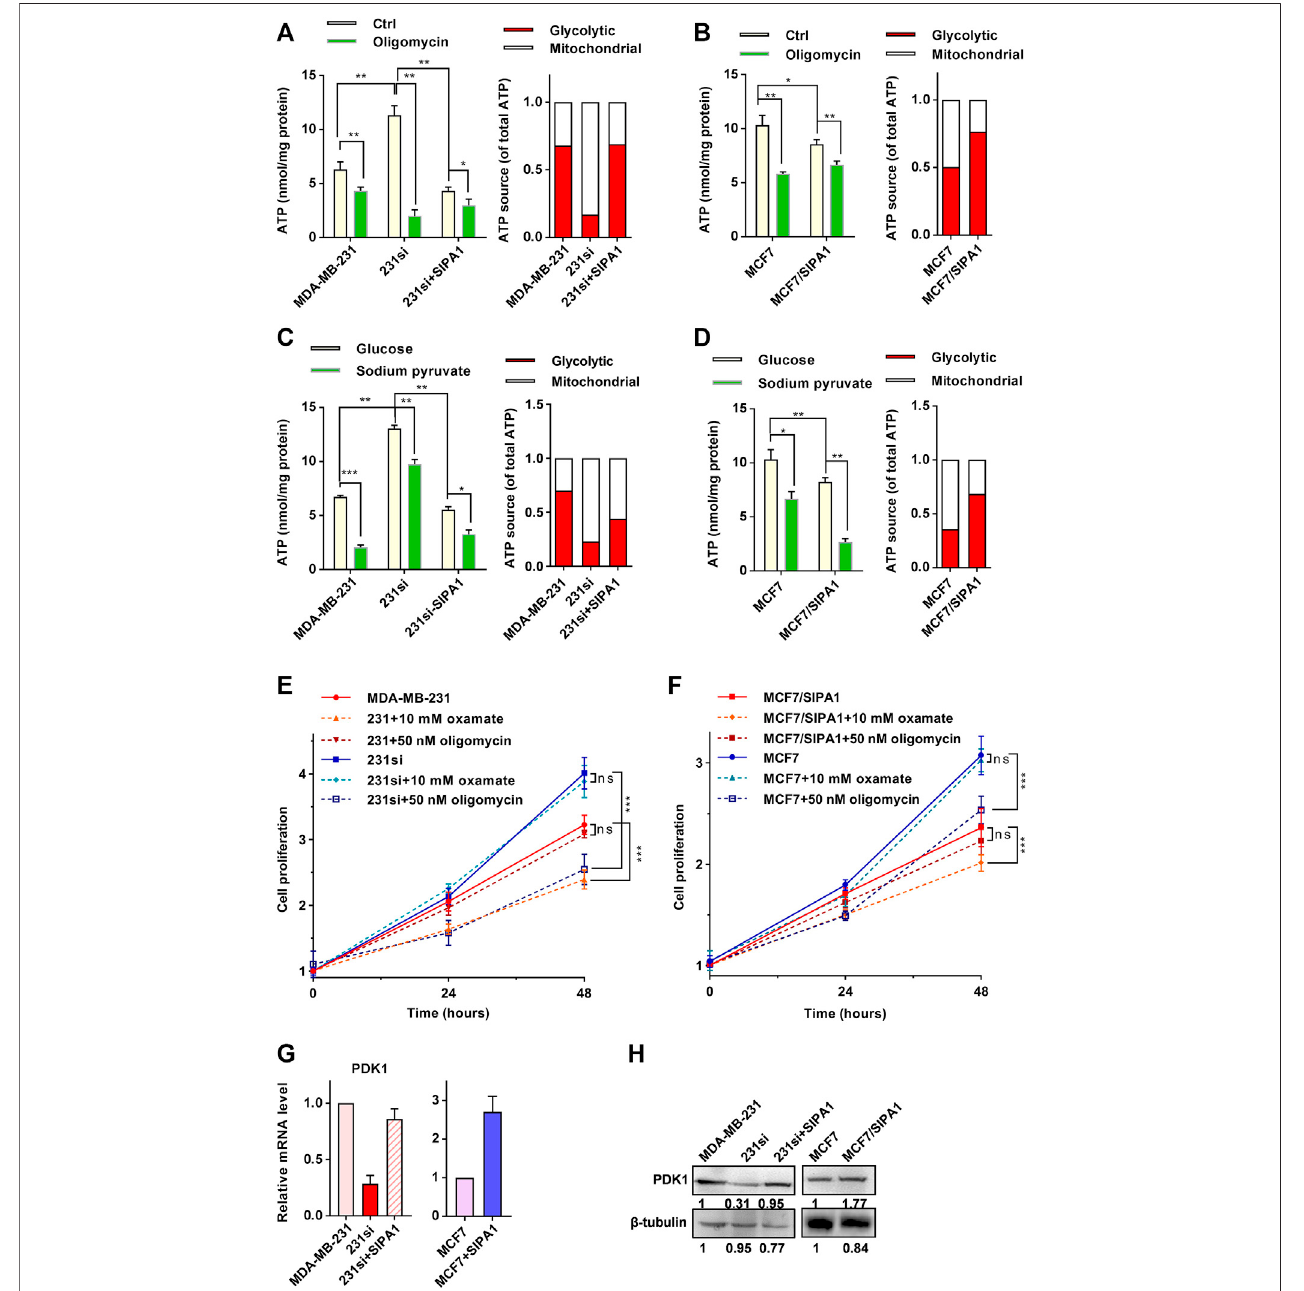
FIGURE 2 | SIPA1 alters ATP production source from respiration to aerobic glycolysis. (A – B) ATP levels in MDA-MB-231 (A) and MCF7 (B) with various SIPA1 expression levels after treatment with oligomycin or not. A mitochondria ATP level was calculated by the following formula (ATP (m) (cid:1) ATP (T) - ATP (g) ), in which total ATP level (ATP (T) ) was measured after incubating cells with 15 mM glucose and the glycolytic ATP (ATP (g) ) were measured after incubating cells with 15 mM glucose and 100 nM oligomycin for 5 h. Yellow bars: control; green bars: oligomycin (left panel). Based on the left panel, the contribution of each ATP source on cellular ATP production was estimated. Red: aerobic glycolysis; white: mitochondrial respiration (right panel). (C – D) Effect of sodium pyruvate as a sole carbon source on ATP production in MDA-MB-231 (C) and MCF7 cells (D) with various SIPA1 expression levels. Cells were grown in the medium containing glucose or sodium pyruvate as a sole carbon source, and the cellular ATP level was measured. Yellow bars, glucose; green bars, sodium pyruvate (left panel). Based on the left panel, the contribution of each ATP source on cellular ATP production was estimated. Red: aerobic glycolysis; white: mitochondrial respiration (right panel). (E – F) Effect of oxamate and oligomycin on the proliferation of MDA-MB-231 (E) and MCF7 cells (F) . (G) mRNA levels of PDK1 were determined by qRT-PCR. (H) Protein levels of PDK1 were determined by Western blotting. Data were shown as mean ± s.d of triplicate measurements (n (cid:1) 3). * p < 0.05, ** p < 0.01, *** p < 0.001, ns, no signi fi cance. (Student ’ s t -test).